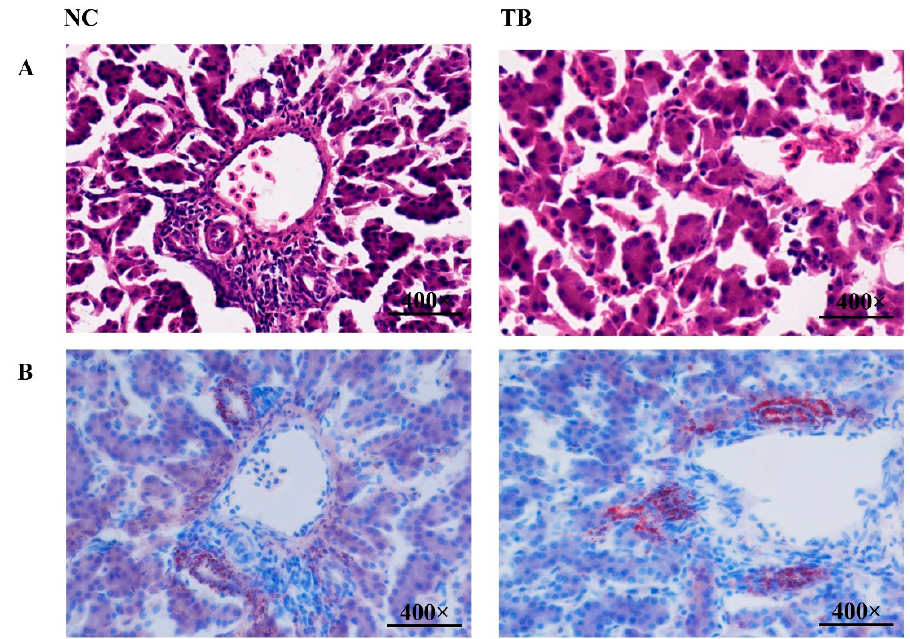
Figure 1. TB increased fat deposition in the liver tissue. ( A ) H&E staining of liver tissue. ( B ) Oil Red O